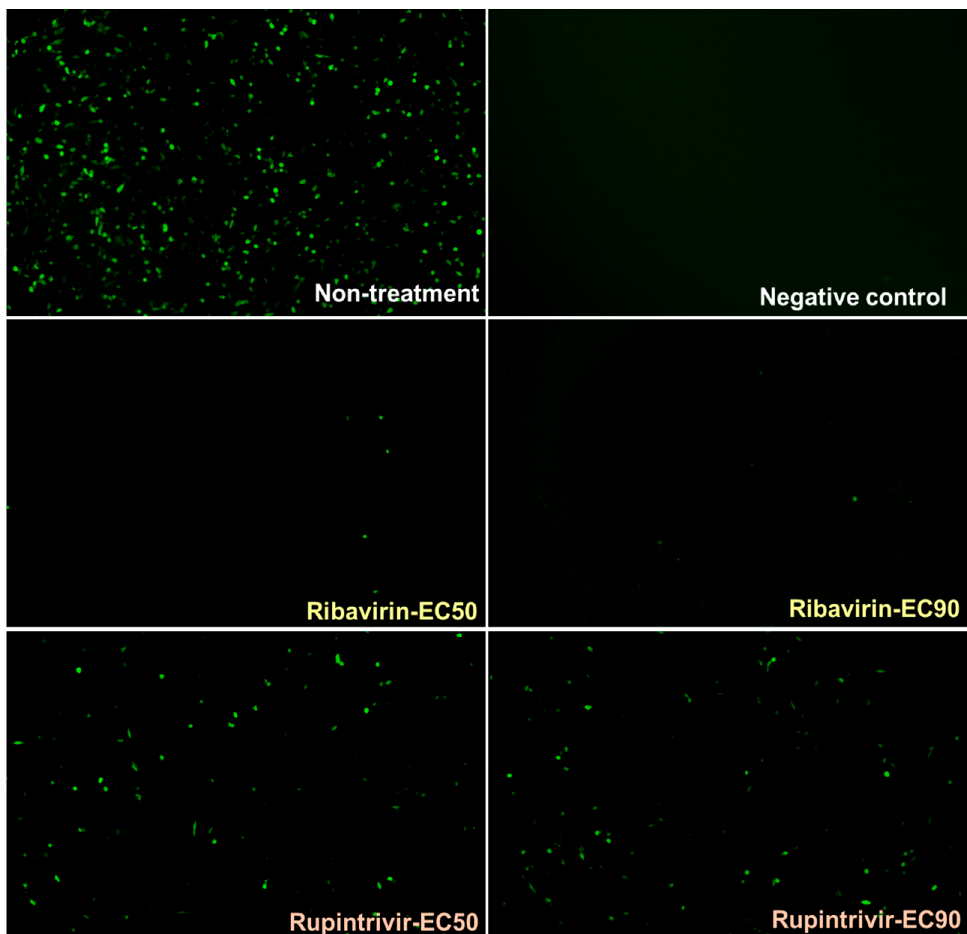
Figure 6. Application of the FMDV minigenome system composing of pKLS3_GFP, pCAGGS_T7, and pCAGGS_P3 in cell-based antiviral drug detection. BHK-21 cells were transfected with the three plasmids, then treated with antiviral agents, including ribavirin and rupintrivir, at EC50 and EC90 doses. Ribavirin inhibited FMDV RdRp leading to dramatically decreased GFP expression level, while rupintrivir significantly decreased the number of the GFP positive cells. The microscopic magnification was 100×.